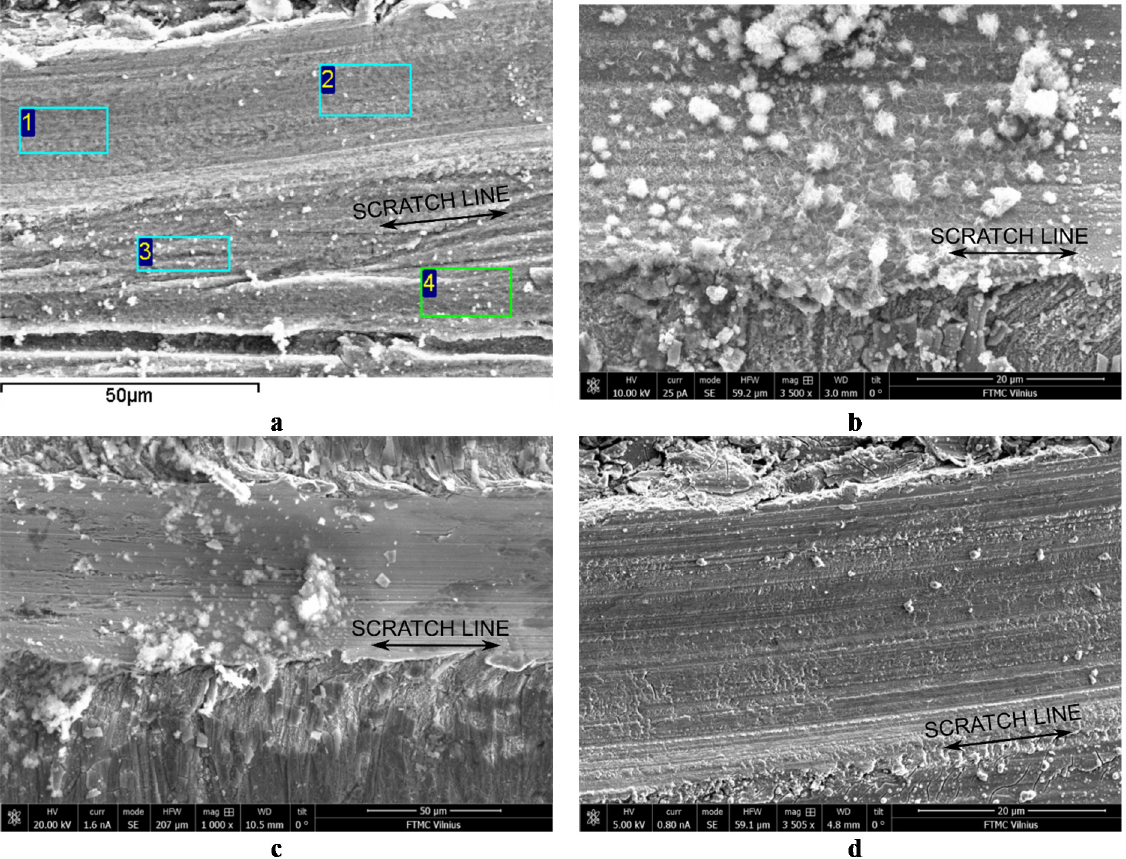
Figure 7. SEM images of scratches on Fe/P-Mo ( a , b ), Fe/P-Mo-Ce1 ( c ) and Fe/Mo-Ce2 ( d ) coatings after immersion in 0.5 M NaCl solution. Exposure time: a —0 h; b —1 h; c —2 h; d —4 h.